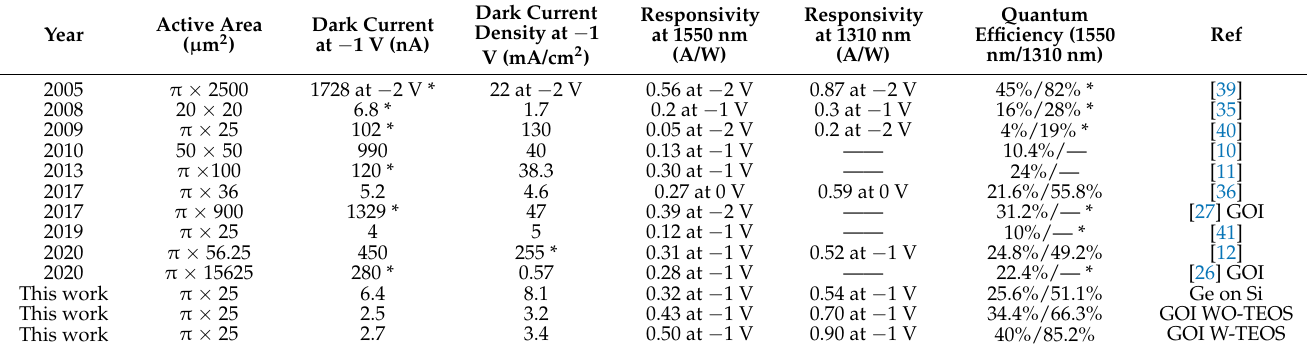
The data have been extracted from the references as indicated. * Data calculated using the referenced material.